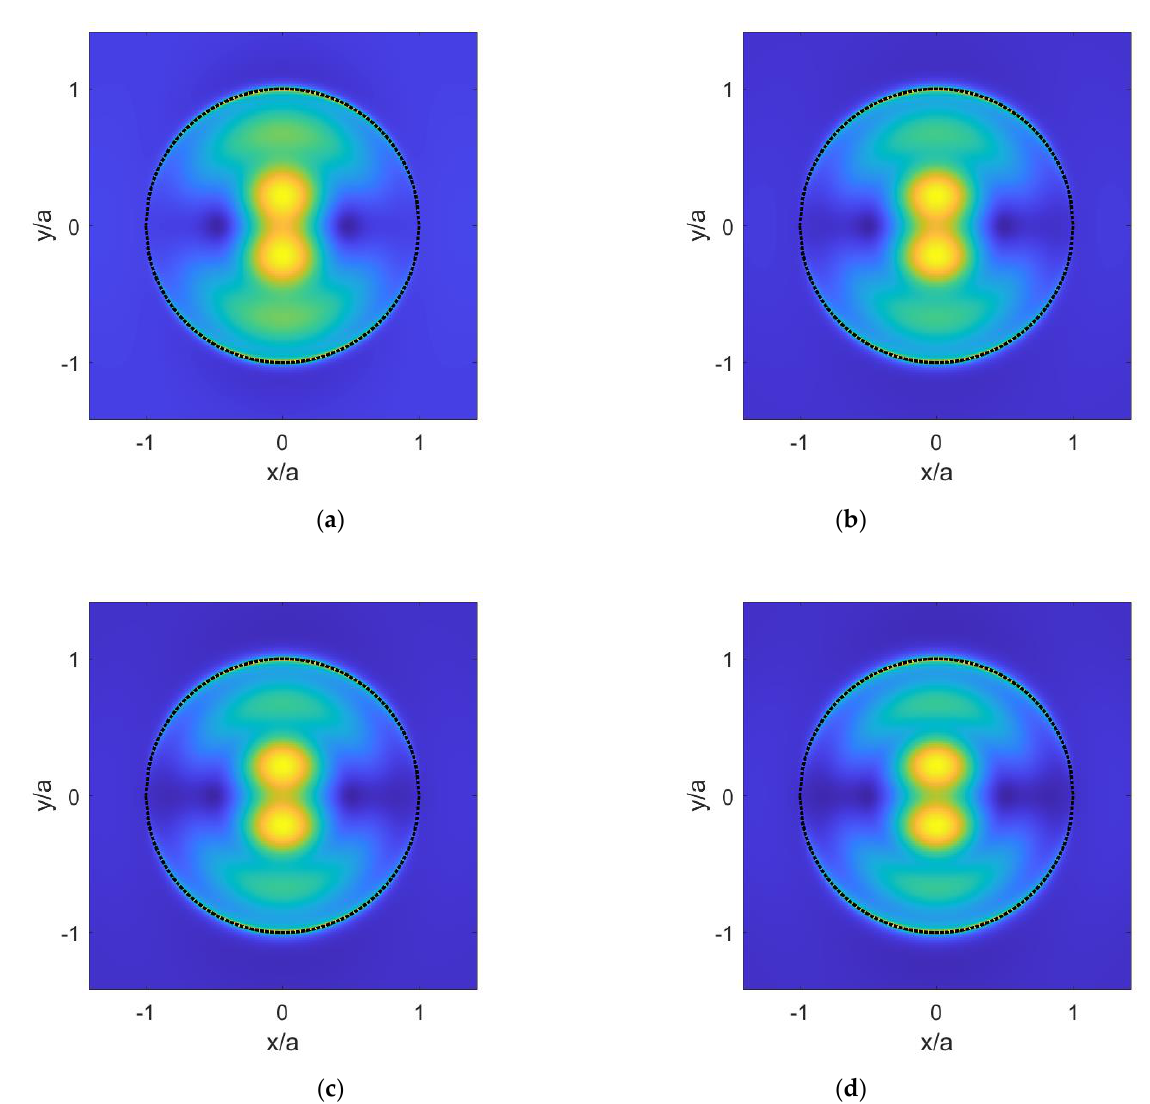
t  , for different relax ˆ E E y  . ( a ) Near E-field for 0 0